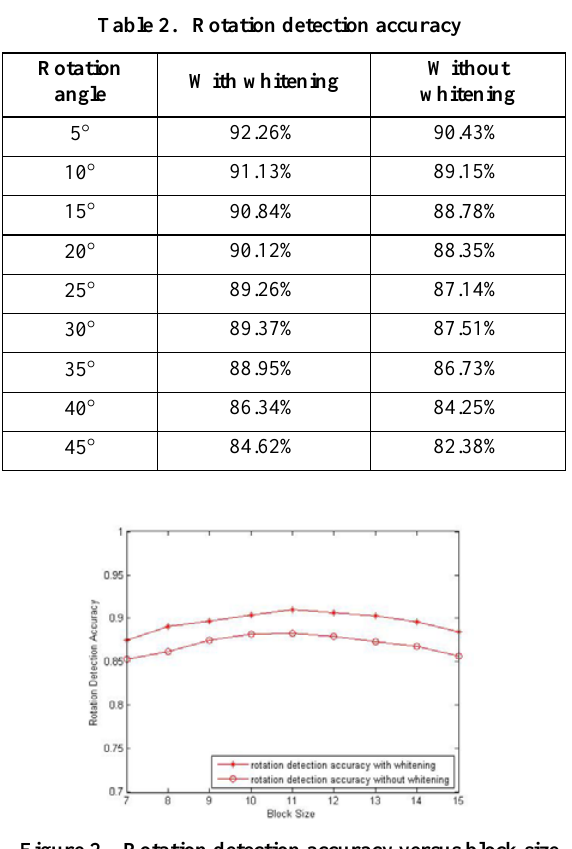
Figure 2. Rotation detection accuracy versus block size